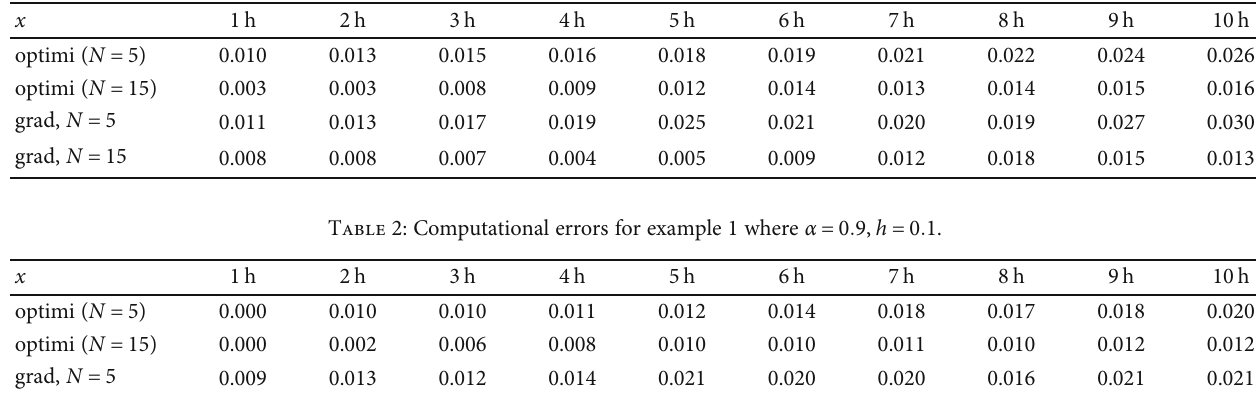
Table 1: Computational errors for example 1 where α = 0 : 5, h = 0 : 1 .